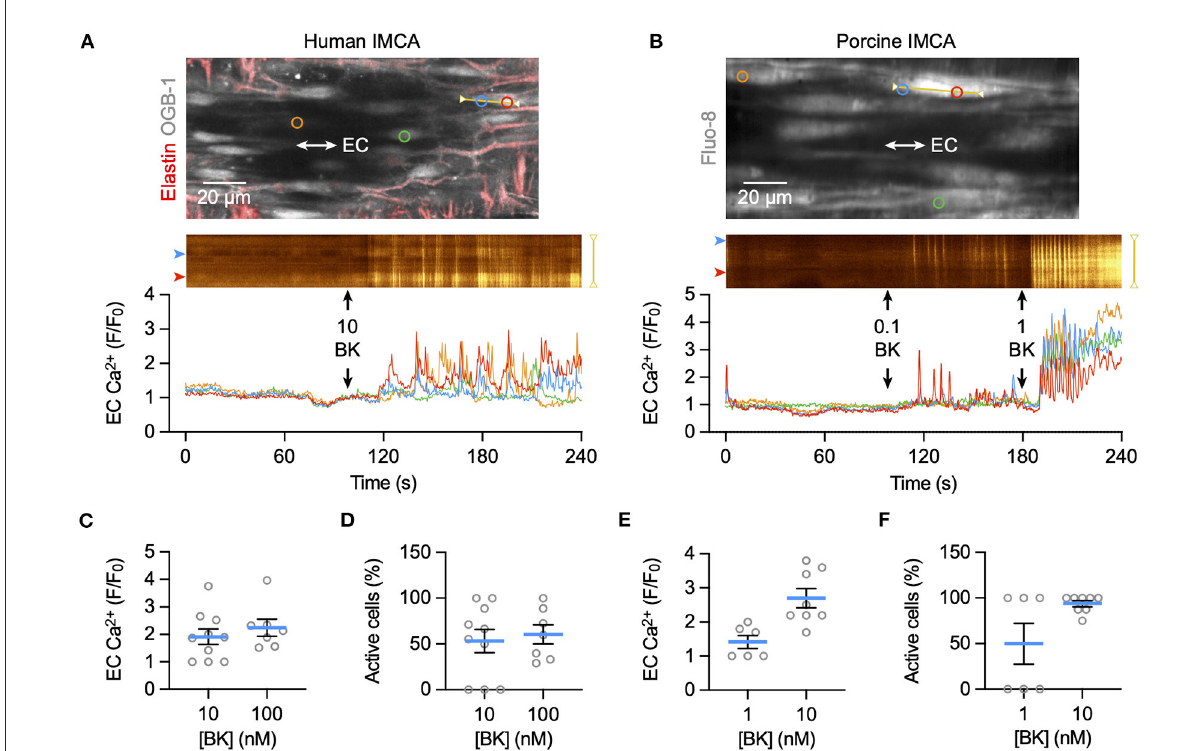
FIGURE5 EC Ca 2 + increase to bradykinin in ex vivo human and porcine RA-IMCAs. Confocal micrographs showing an isolated, cannulated and pressurized human IMCA (A) and porcine IMCA (B) loaded with Ca 2 + indicator to image ECs near the bottom plane of the artery. Longitudinal (IEL) and radial strands of elastin are visible in the human artery (labeled with AF-633, red). The spatio-temporal characteristics of EC Ca 2 + events are shown in line-scan analysis of each yellow line, and the average fluorescence intensity within each colored circle as F/F 0 in the traces below. The addition of each concentration (nM) of bradykinin (BK) to the chamber is indicated by arrows. Summary of EC Ca 2 + responses to BK as F/F 0 and percentage of active cells, in human (C,D) and porcine (E,F)